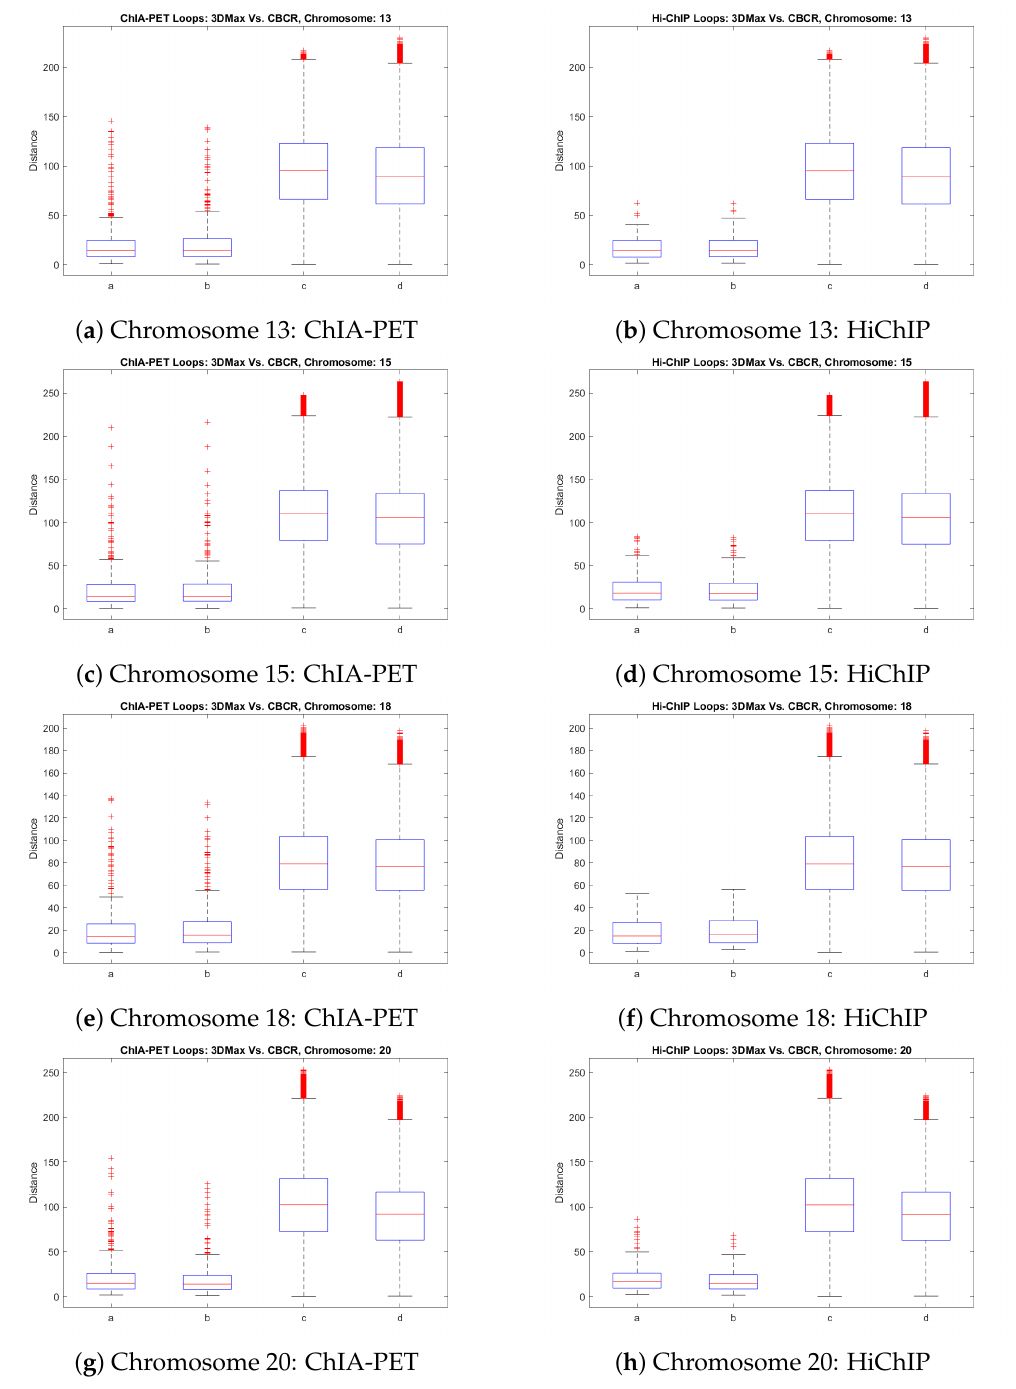
Figure 19. Comparison of the loop and non-loop model distances between CBCR and 3DMax at 100 kb for the HiChIP and ChIA-PET data. The first and third boxes in each plot correspond to CBCR and the second and fourth boxes correspond to